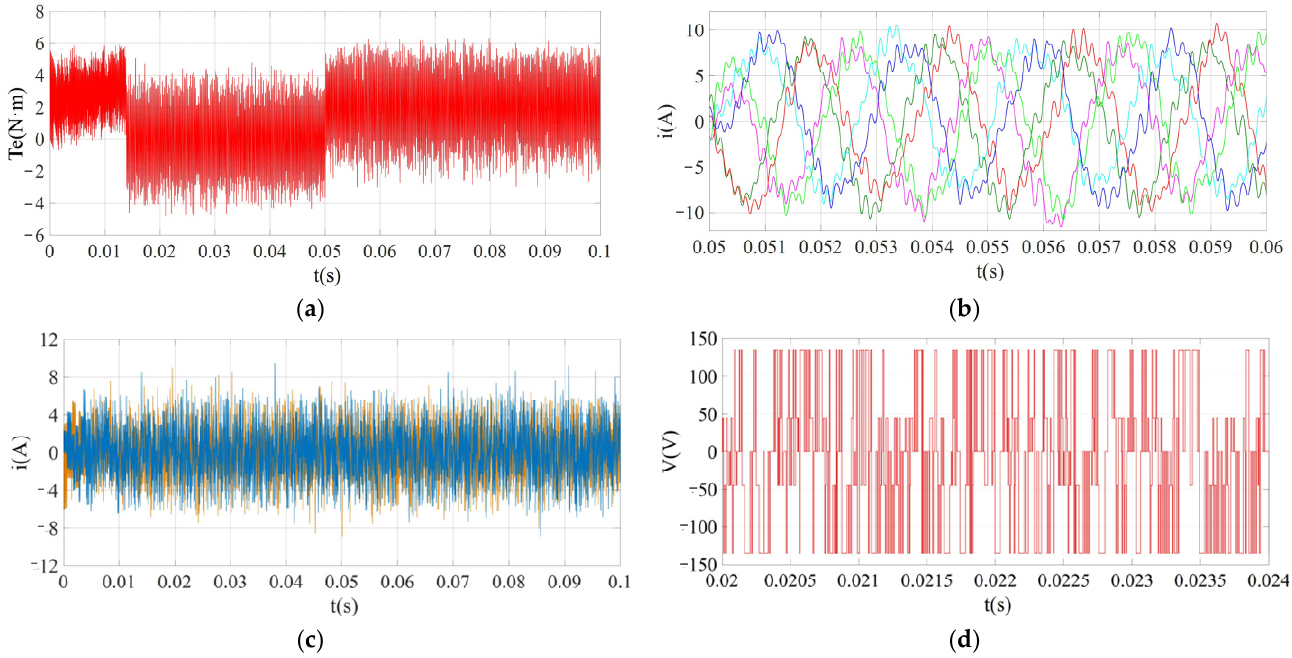
Figure 9. Output performance of traditional MPTC: ( a ) output torque; ( b ) six-phase stator current; ( c ) harmonic current components in x-y subplace; ( d ) common-mode voltage.